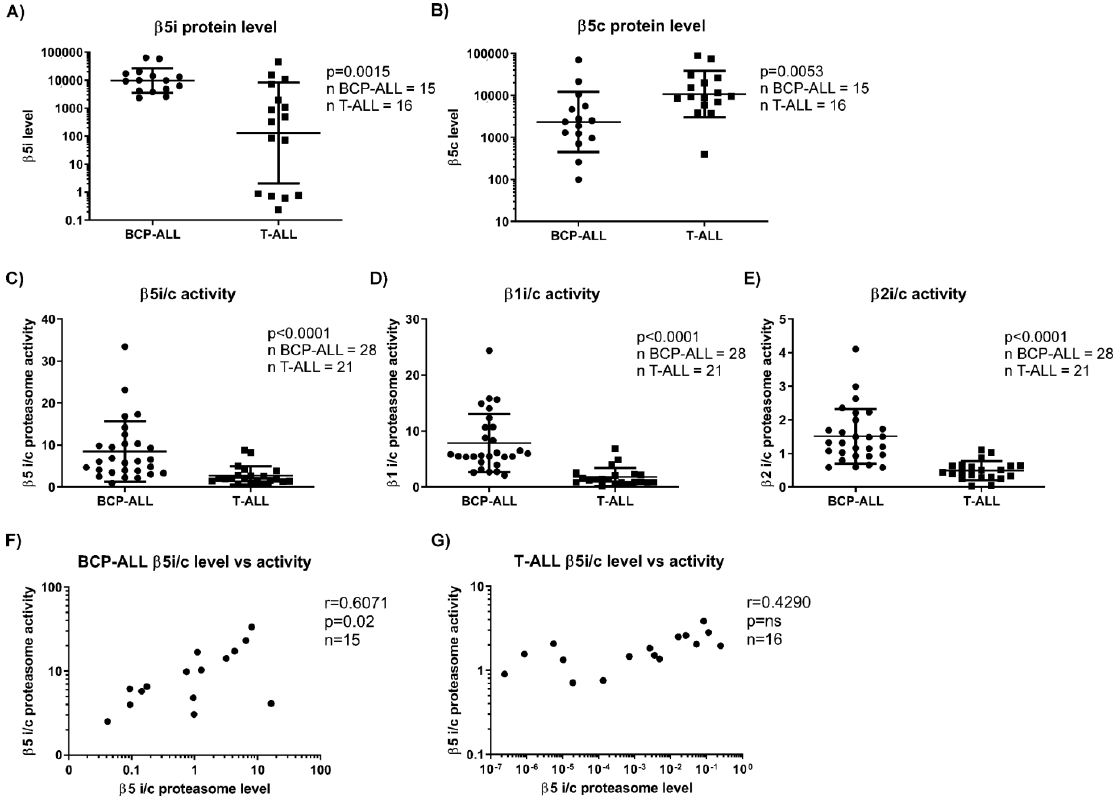
Figure 1. Expression levels and activity of the immunoproteasome vs. constitutive proteasome in BCP-ALL and T-ALL. ( A ) Comparison of levels of the constitutive proteasome β 5 subunit ( β 5c) between BCP-ALL and T-ALL samples. Data represent geometric mean ± SD. p was obtained with Mann–Whitney U test. ( B ) Comparison of levels of the immunoproteasome β 5 subunit ( β 5i) between BCP-ALL and T-ALL samples. Data represent geometric mean ± SD. p was obtained with Mann– Whitney U test. ( C ) Comparison between the ratio of activity of proteasome β 5i versus β 5c. Data represent mean ± SD. p was obtained with Mann–Whitney U test. ( D ) Comparison between the ratio of activity of proteasome β 1i versus β 1c. Data represent mean ± SD. p was obtained with Mann–Whitney U test. ( E ) Comparison between the ratio of activity of proteasome β 2i versus β 2c. Data represent mean ± SD. p was obtained with Mann–Whitney U test. ( F ) Correlation between the ratio of activity of proteasome β 5i versus β 5c subunits and the ratio of expression levels of proteasome β 5i versus β 5c subunits in BCP-ALL samples. r and p were obtained with Spearman’s correlation. ( G ) Correlation between the ratio of activity of proteasome β 5i versus β 5c subunits and the ratio of expression levels of proteasome β 5i versus β 5c subunits in T-ALL samples. r and p were obtained with Spearman’s correlation. BCP-ALL = B-cell precursor acute lymphoblastic leukemia, T-ALL = T-lineage acute lymphoblastic leukemia, i = immunoproteasome, c = constitutive